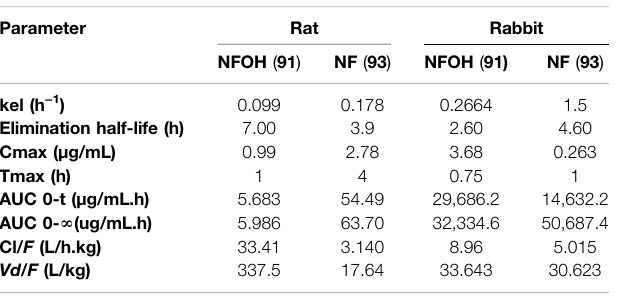
TABLE 5 | Pharmacokinetic parameters determined after a single dose (200 mg/kg) of NF ( 93 ) and NFOH ( 91 ) in Wistar rats (Sera fi m et al., 2013) and in rabbits (Nogueira et al.,